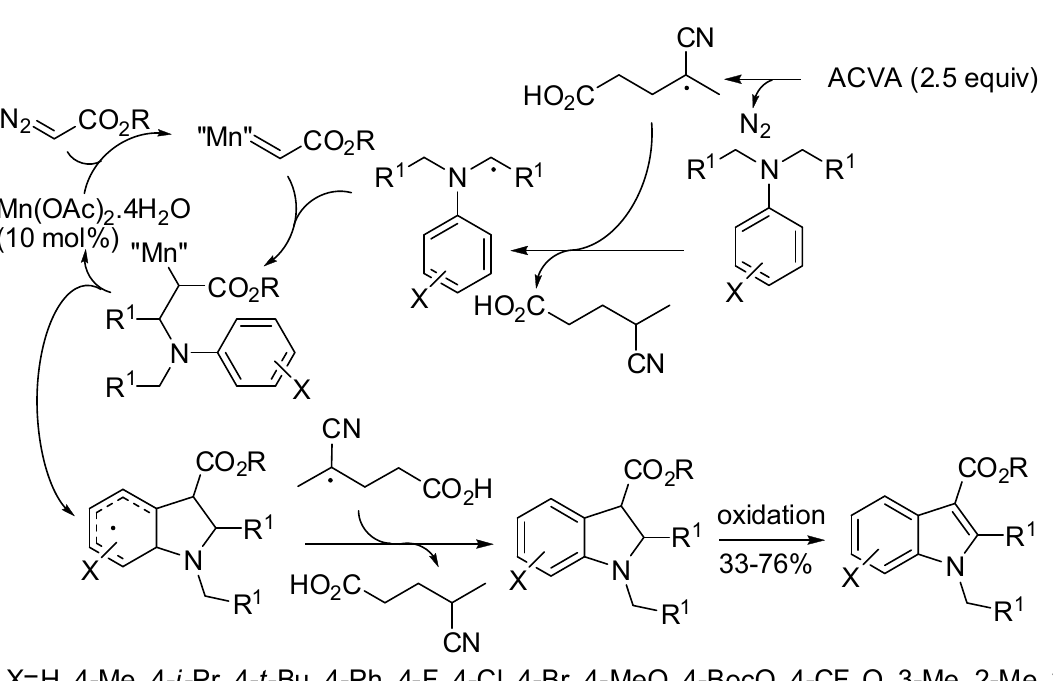
Scheme 74. Mn-catalyzed synthesis of indoles from aromatic amines and diazo compounds.